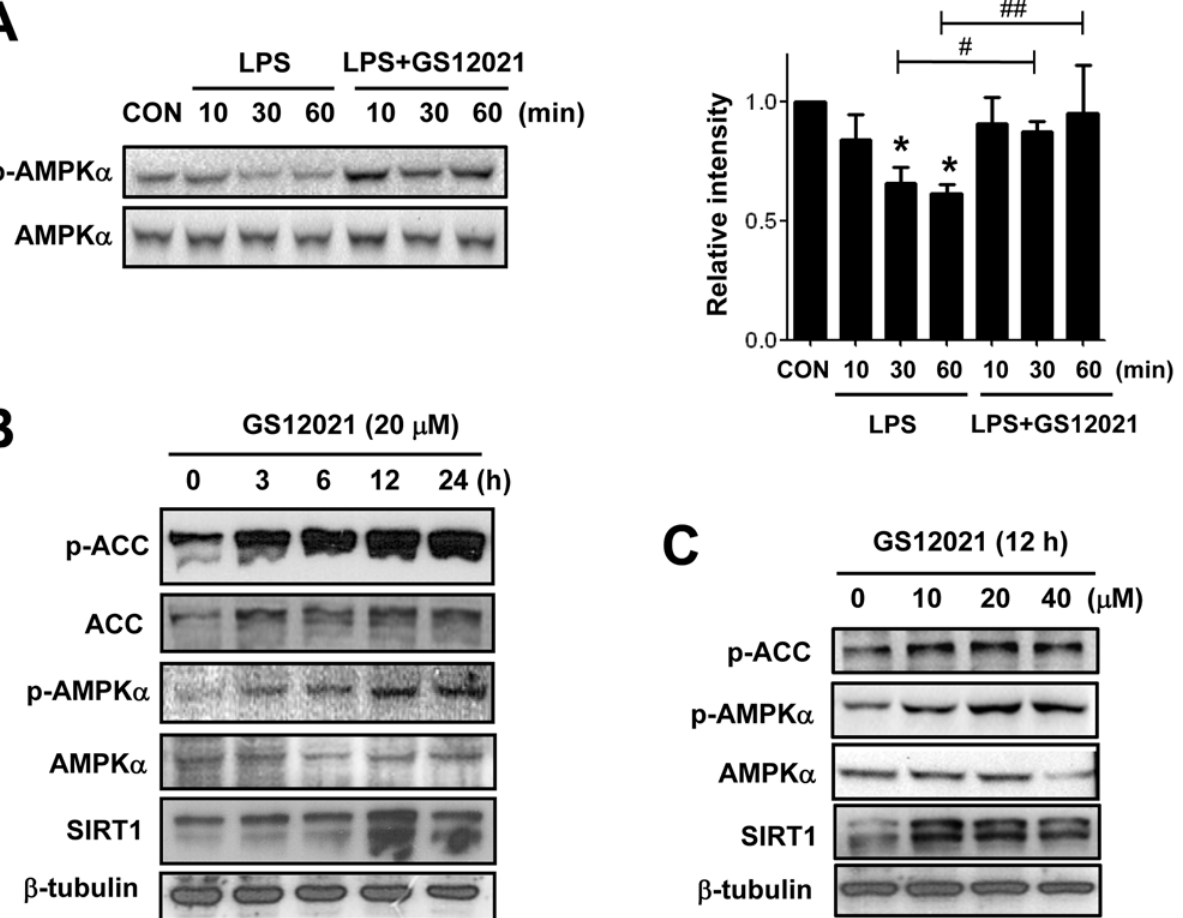
Fig 6. Effect of GS12021 treatment on AMPK α activation and SIRT1 expression in RAW 264.7 cells. (A) Levels of phosphorylated AMPK α and total AMPK α were measured by western blotting. Cells were pretreated with vehicle or GS12021 (20 μ M for 1 h) and stimulated with LPS for the time periods indicated. Quantification results are shown in the right panel. * P < 0.05 versus CON; # P < 0.05, ## P < 0.01 versus LPS alone. (B) Cells were treated with GS12021 (20 μ M) for the indicated time periods and western blotting was performed with specific antibodies against p-ACC, p-AMPK α , and SIRT1. β -tubulin was used as a loading control. (C) Concentration-dependent effect of GS12021 on AMPK activation and SIRT1 expression. Cells were treated with different concentrations of GS12021 for 12 h, and western blotting analyses were